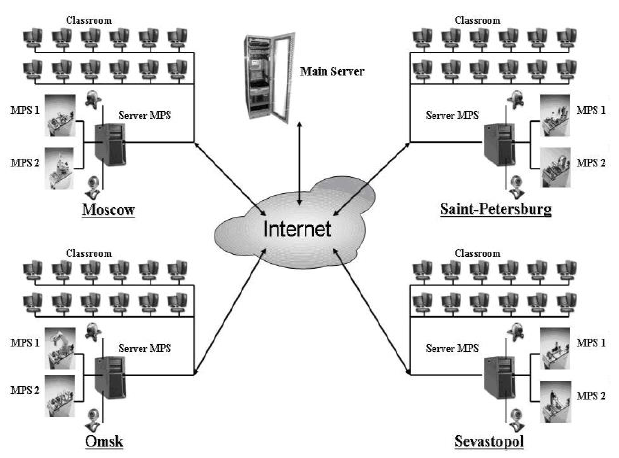
Figure 2. Organizational structure of the system of access to equipment